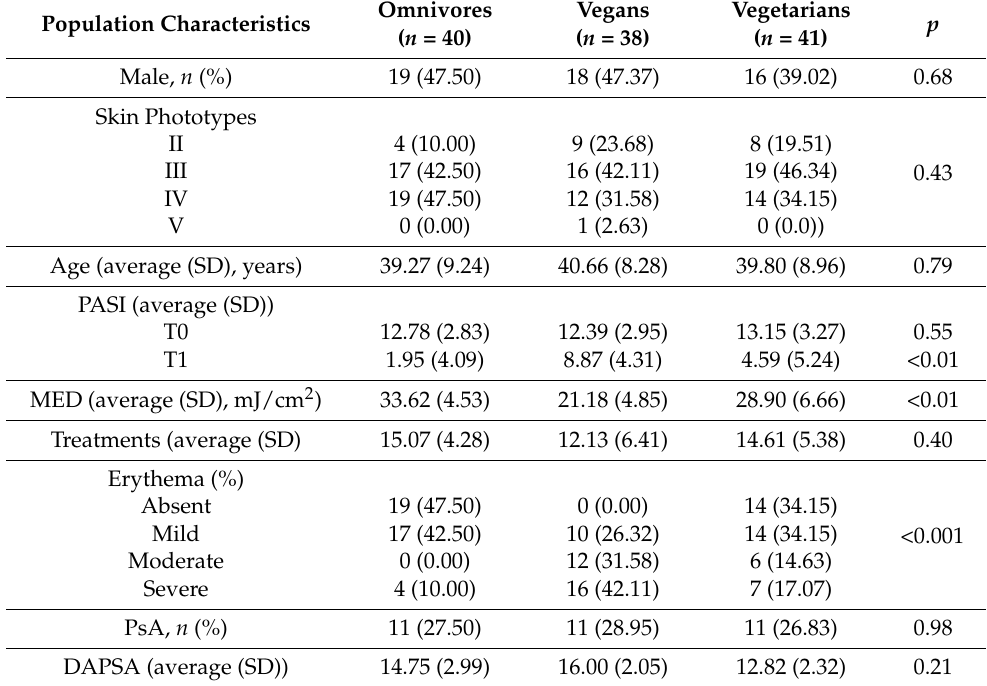
Table 1. Socio-demographic and clinical characteristics of omnivores, vegetarians and